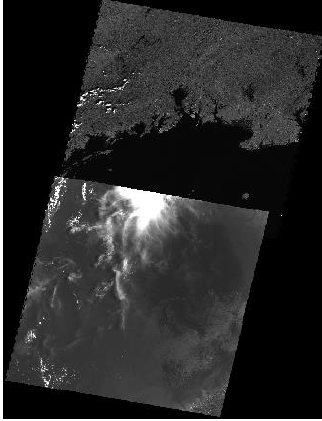
Figure.11 the image of North gulf, Guangxi,